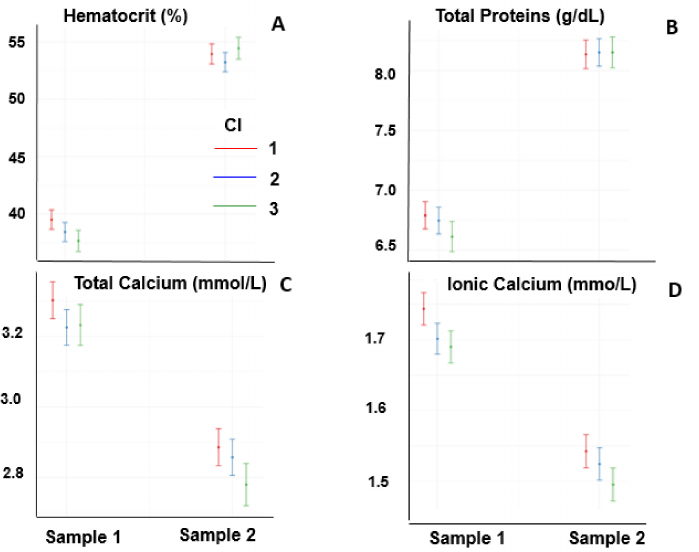
Figure 1. Hematocrit ( A ), total plasma protein ( B ), total calcium ( C ), and ionic calcium ( D ) of horses one day before the race (Sample 1) and at the end of race (Sample 2).